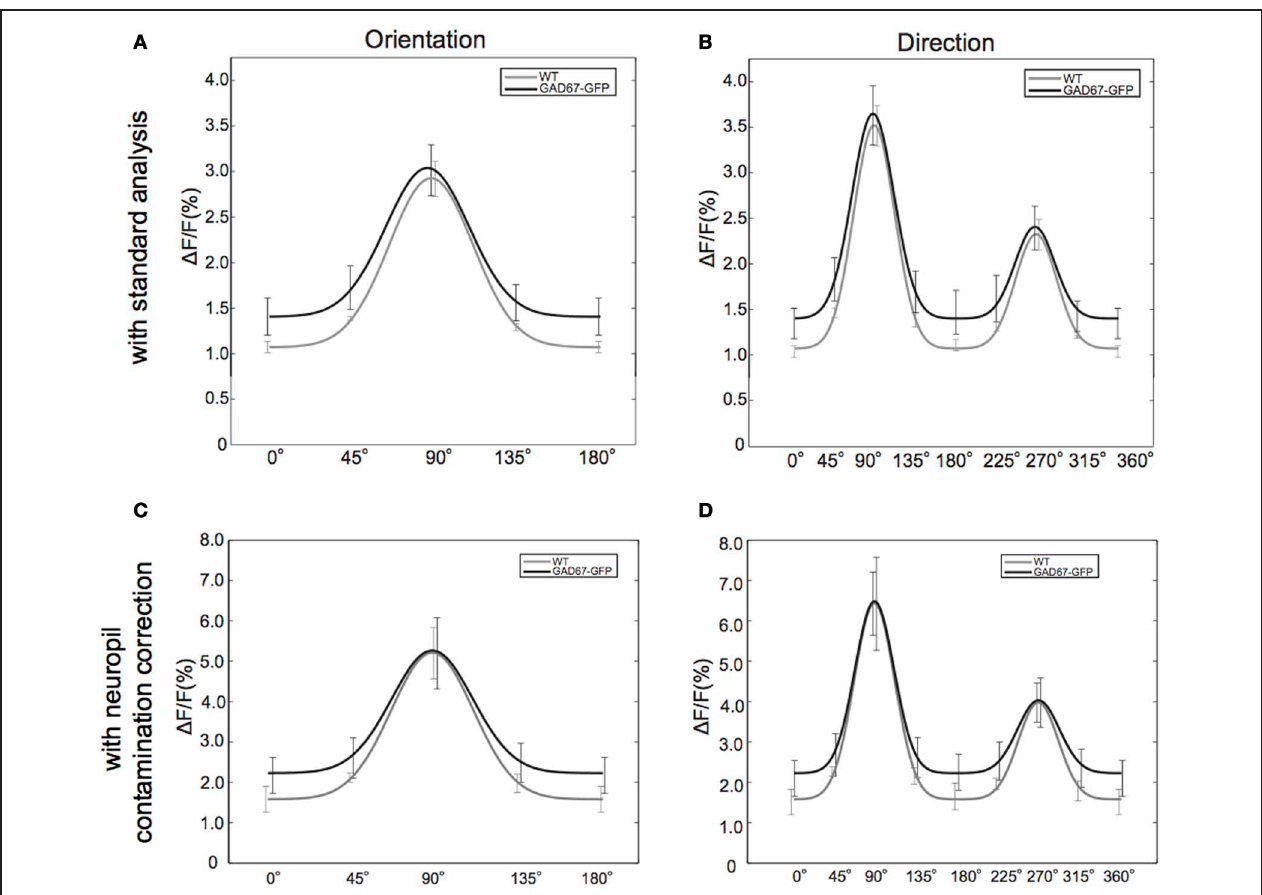
FIGURE 3 | Tuning curves of the response to each orientation and direction. (A,B) Orientation (A) and direction (B) tuning curves are plotted after sifting preferred orientation or direction to 90 ◦ , averaging response magnitude and fitting with a Gaussian function (see Materials and Methods).